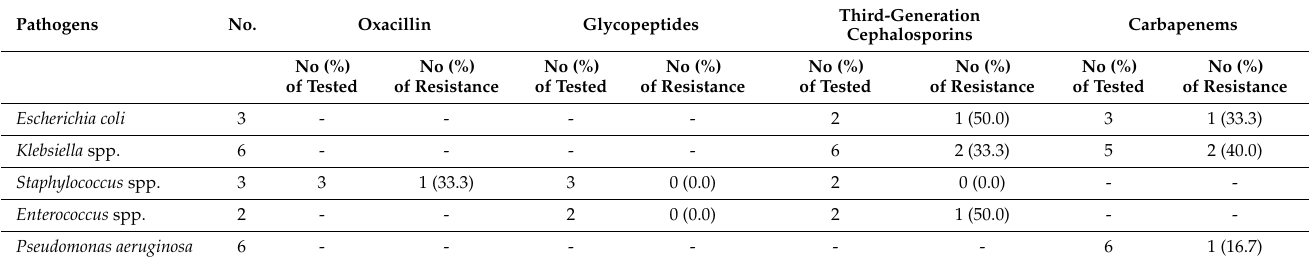
Table 3. Antimicrobial resistance of tested microorganisms.